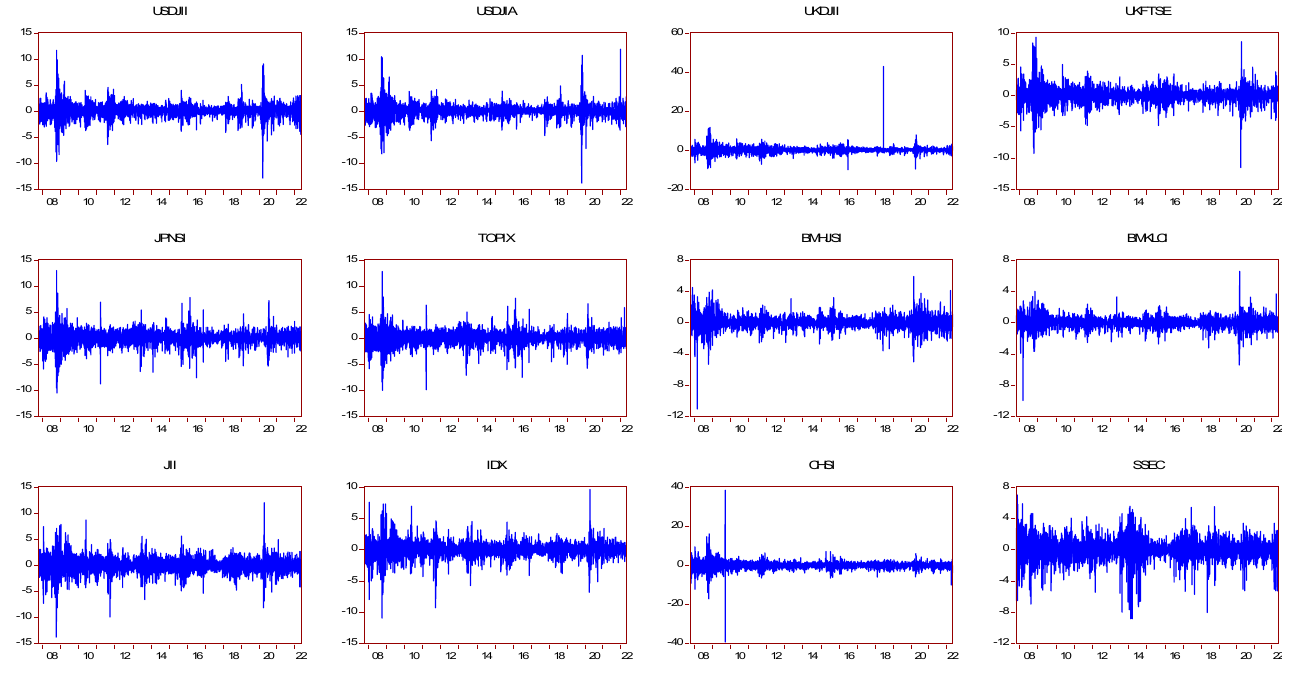
Figure 3. Stock price return movement.